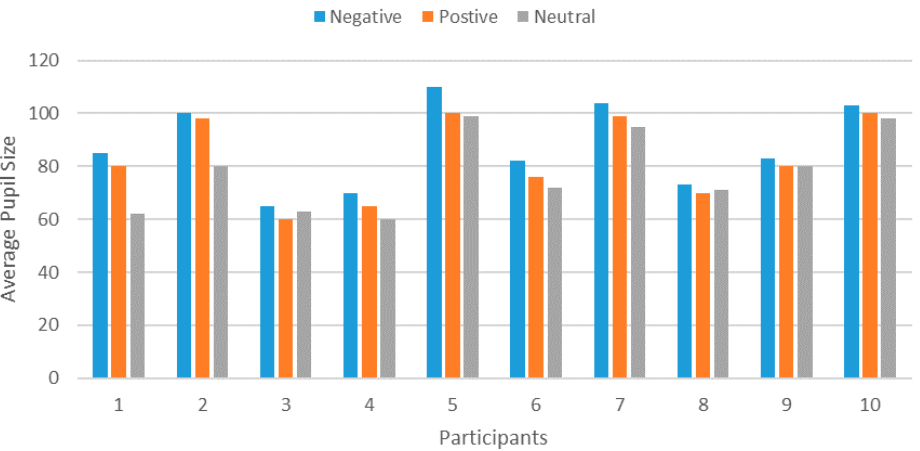
Figure 16. The average pupil size of each trail.